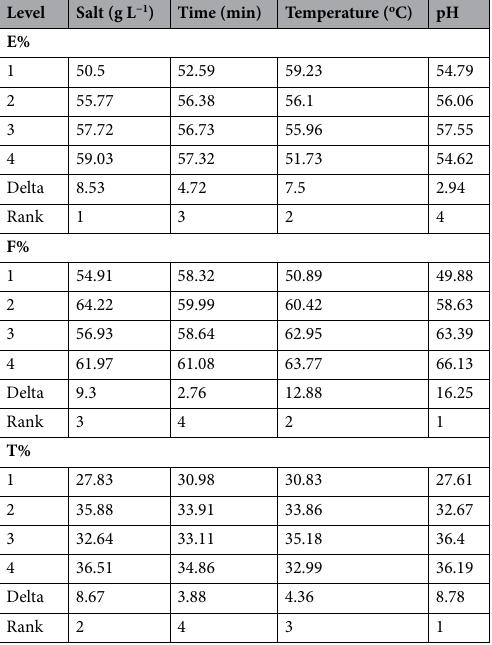
Table 7. Response table for the means in E%, F%, and T% of